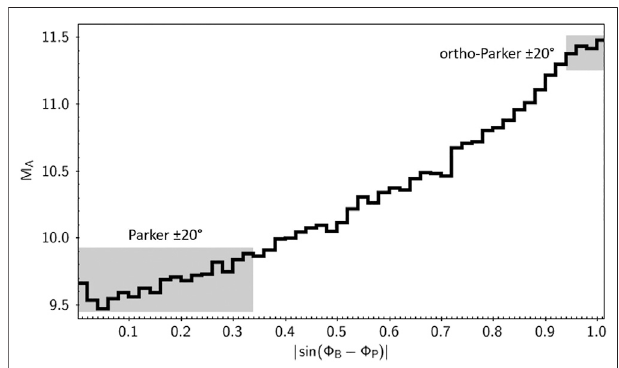
FIGURE1| AverageoftheMachAlfvénnumberperbinof|sin( Φ B − Φ P )|. Parker orientations ± 20 ° are shown in the grey box on the left and the ortho- Parker orientations ± 20 ° are shown in the upper right grey